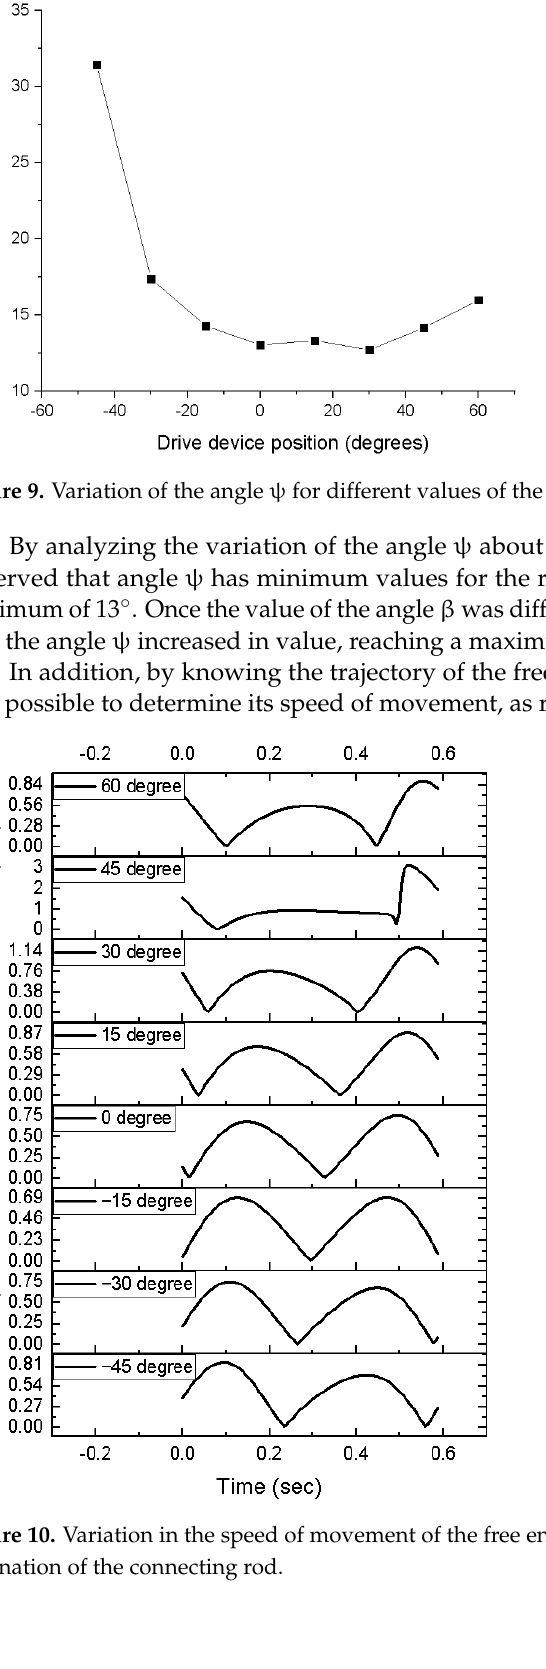
Figure 10. Variation in the speed of movement of the free end of the tie rod depends on the angle of inclination of the connecting rod.